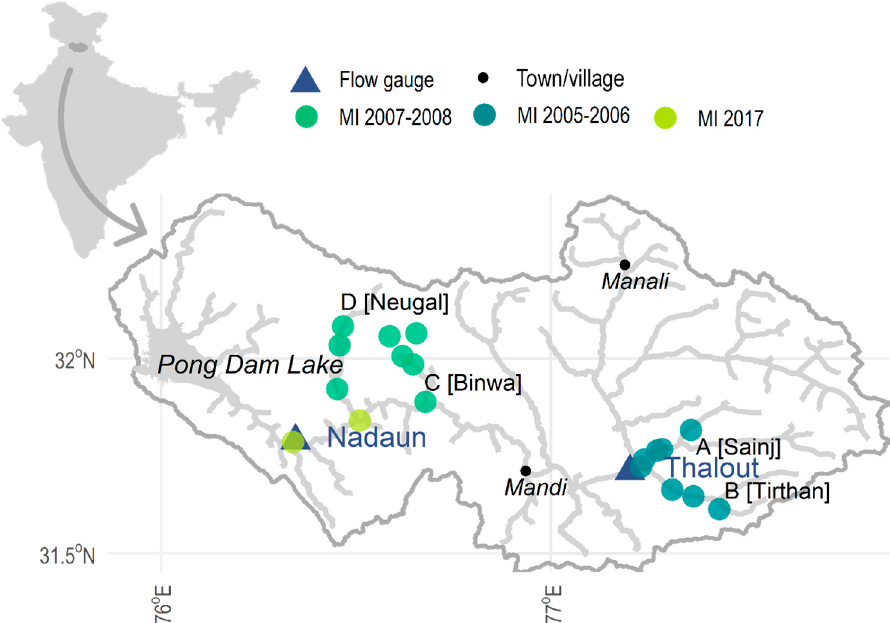
Figure 3 . Map of the Beas River Basin and its situation (inset top left); the locations of the flow gauges and macroinvertebrate (MI) sampling are indicated.